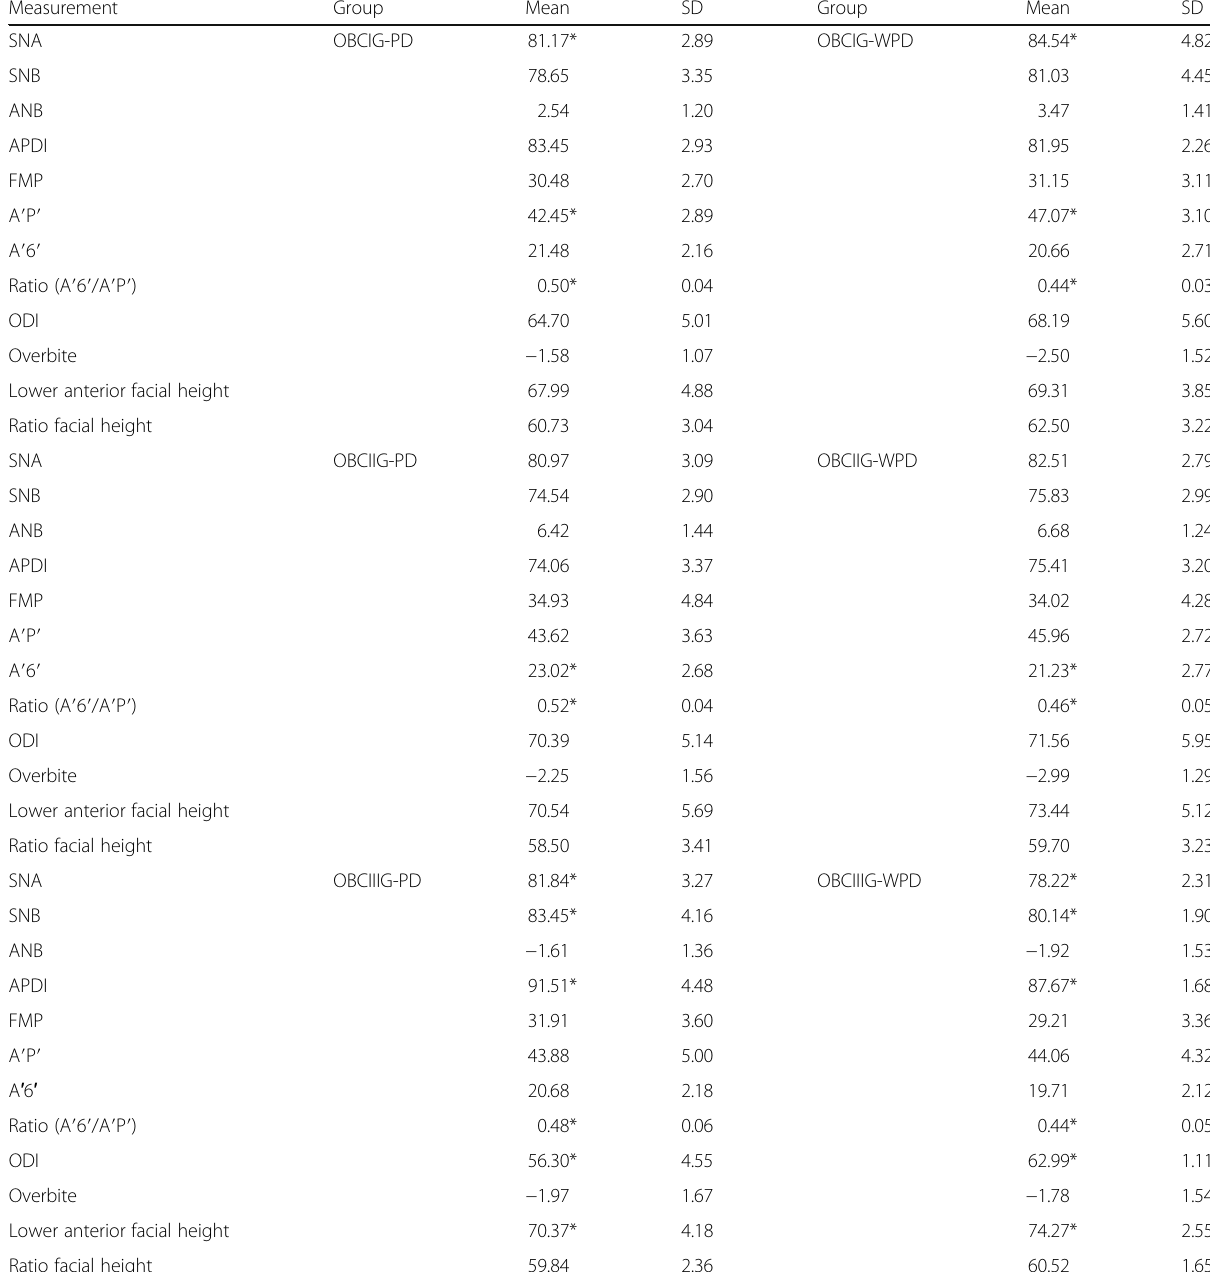
Table 3 Sample characteristics by facial growth pattern and maxillary posterior dentoalveolar discrepancy